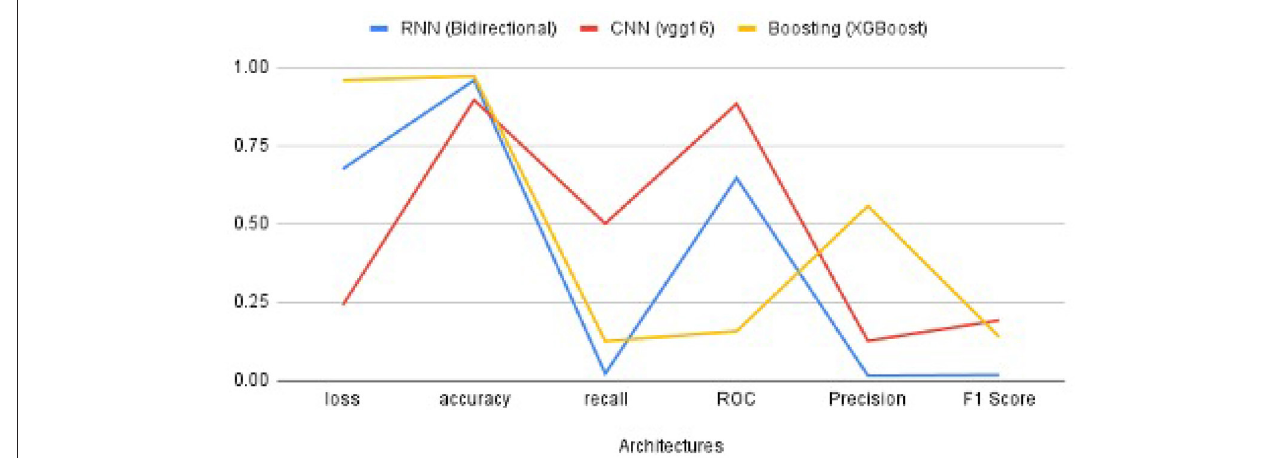
FIGURE 9 | The comparison of performance metrics of CNN, RNN, and XG-Boost.